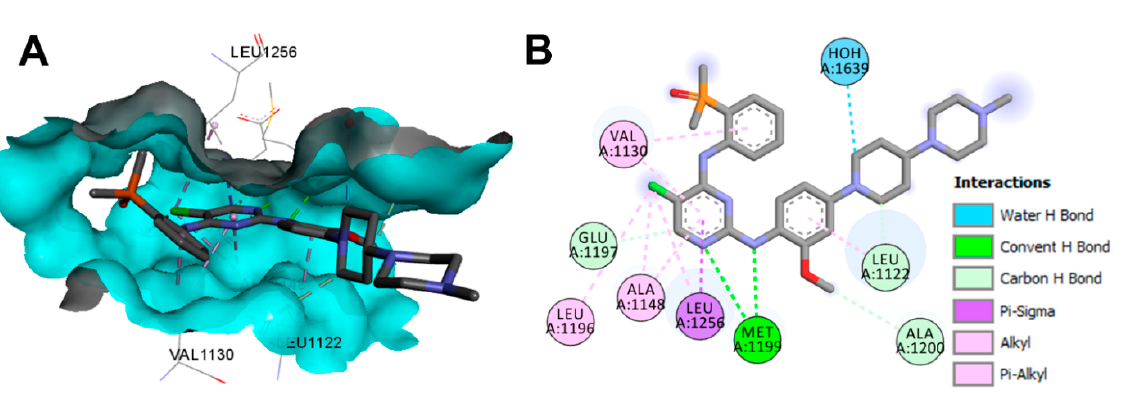
Figure 18. Binding modes of brigatinib (shown as sticks) into EGFR C797S (pdb: 7AEM): ( A ) 3D binding mode, receptor shown as hydrogen bond surface; ( B ) 2D binding mode showing different types of binding interactions; the figure was generated using Discovery Studio Visualizer (V16.1.0.15350).